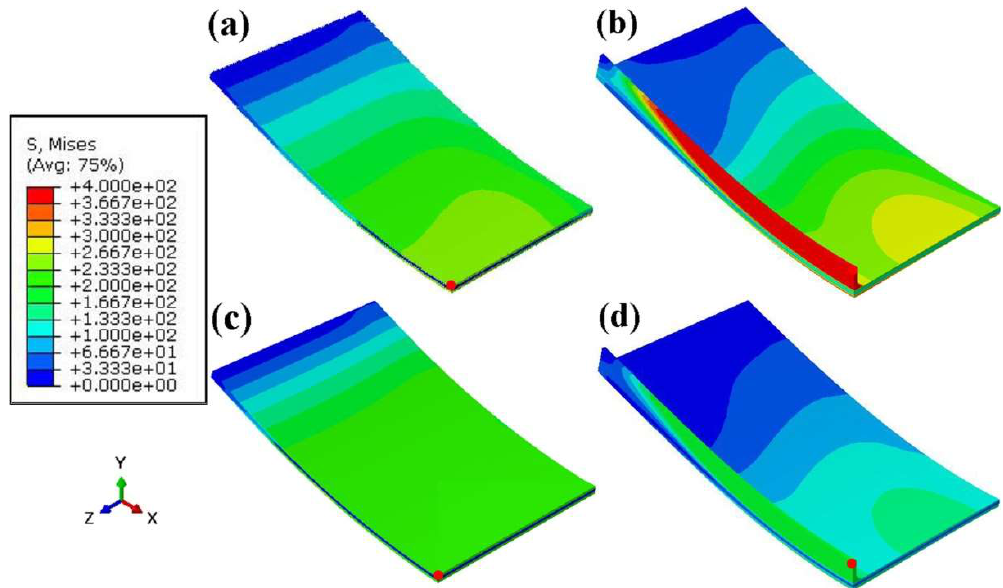
Figure 14. Mises stress distribution of AA7050 ribbed panels: ( a ) h/t = 0, creep aged 0 h; ( b ) h/t = 3, creep aged 0 h; ( c ) h/t = 0, creep aged 12 h; and, ( d ) h/t = 3, creep aged 12 h.